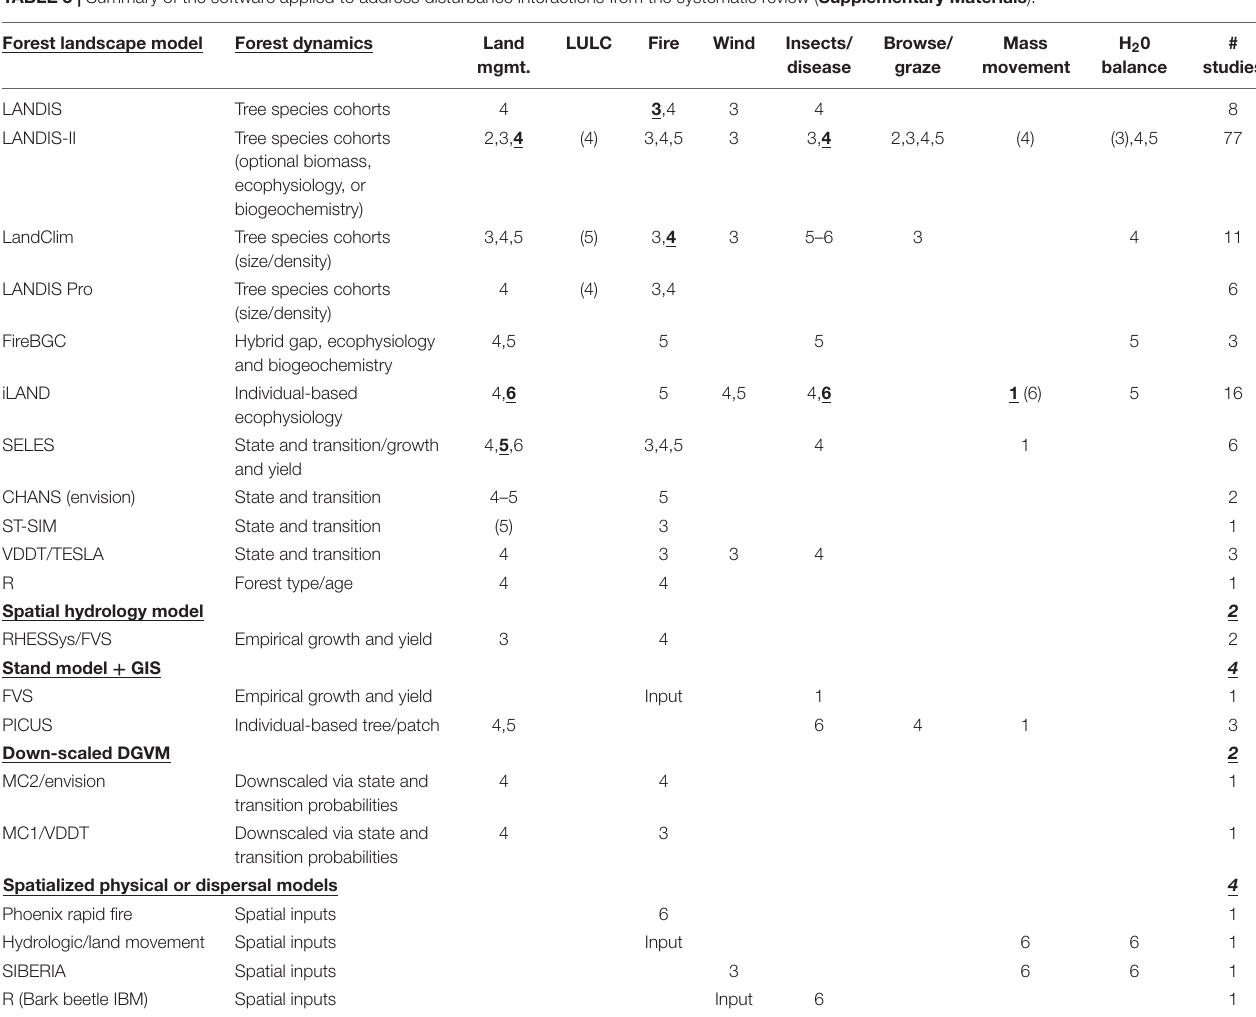
Numbers under each disturbance type reflects the different levels of process integration applied for each type ( Table 4 ). Note that the absence of a value under a given disturbance type does not mean the software is not capable of simulating that type, it simply was not present in the pool of studies from our review. Bold underscore indicates dominant mode in applications. Numbers in parentheses indicate an external coupled